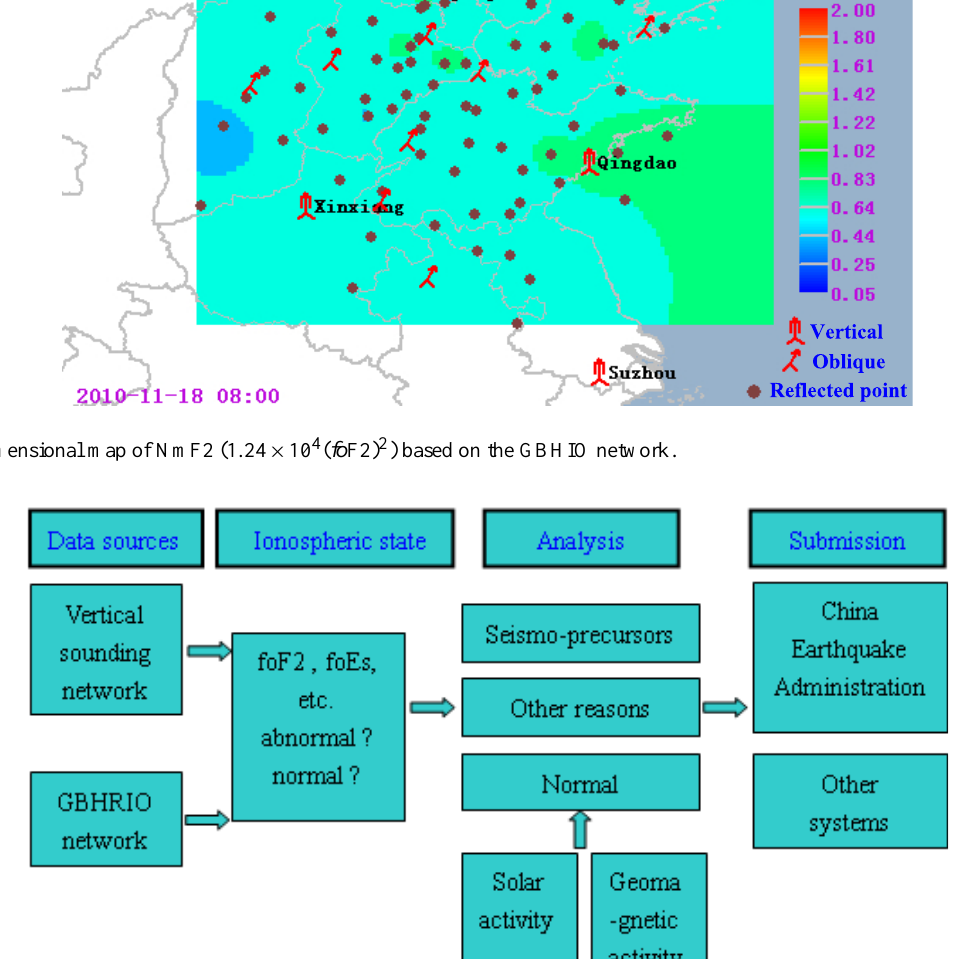
Fig. 8. The flow process of monitoring anomalous ionospheric variation related to seismic activity in the GBHIO.